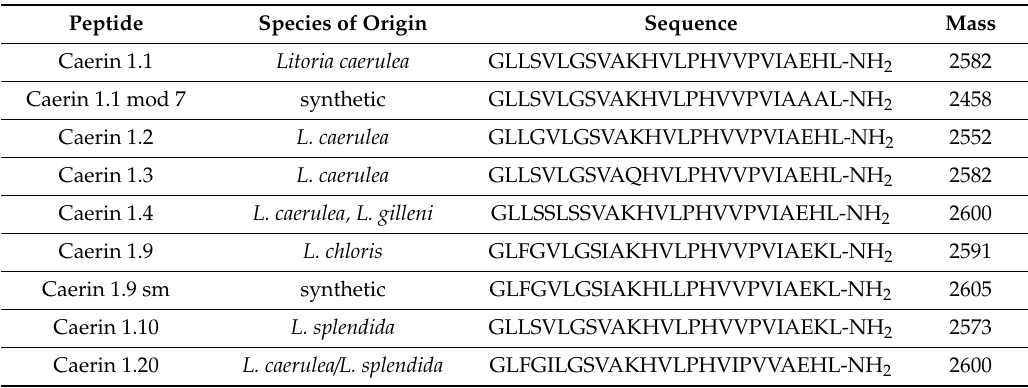
Table 1. Caerin 1 Antimicrobial